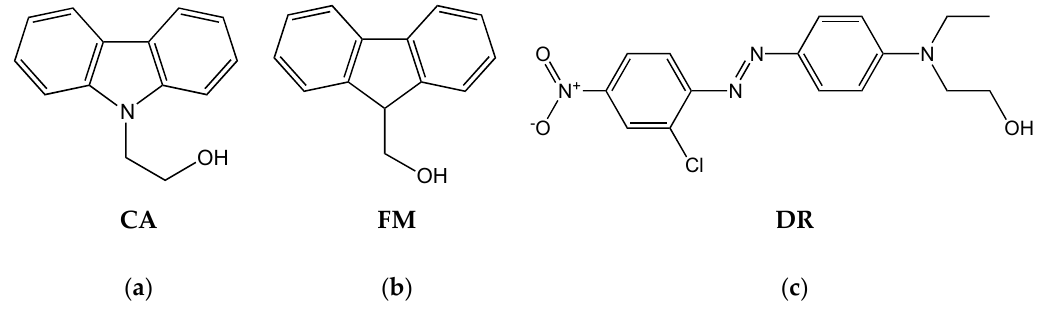
Figure 1. ( a ) 9H-carbazol-ethanol (CA), ( b ) 9-fluorenyl-methanol (FM), and ( c ) 2-(4-(2-chloro-4-nitrophenylazo)-N-ethylphenylamino)ethanol (Disperse Red 13, DR).